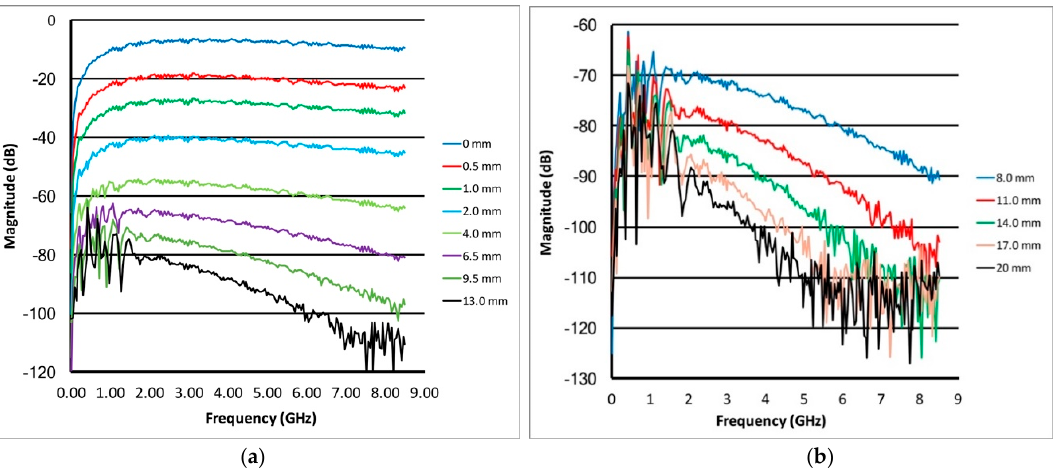
Figure 3. Magnitude plots for the transmission probes as a function of frequency for ( a ) a set of closer spacings (0–13 mm) and ( b ) a set of more distant spacings (8–20 mm), respectively, for a 20:80 glycerin:water coupling bath.